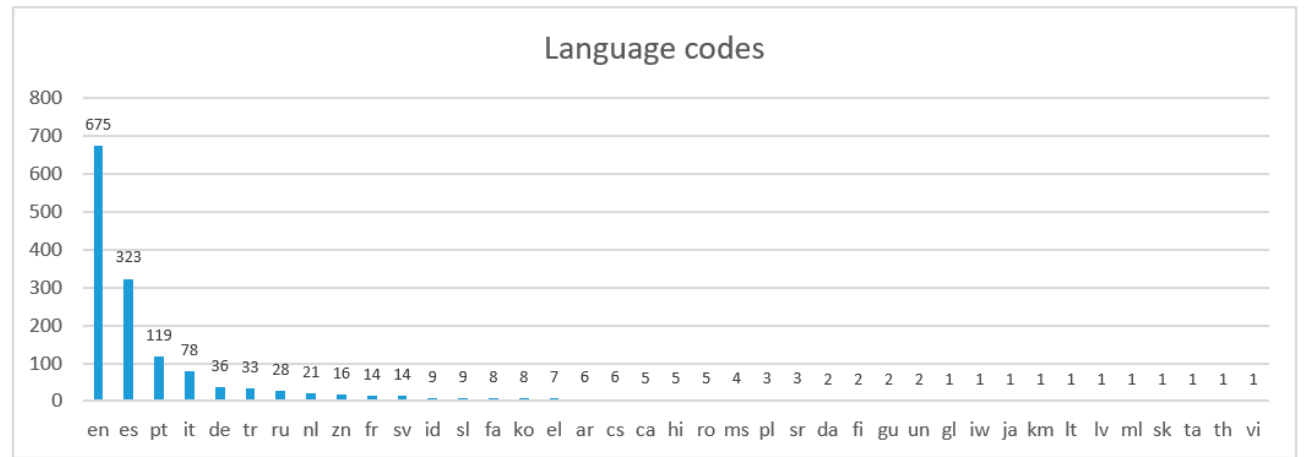
Figure 9. Posts’ language codes.